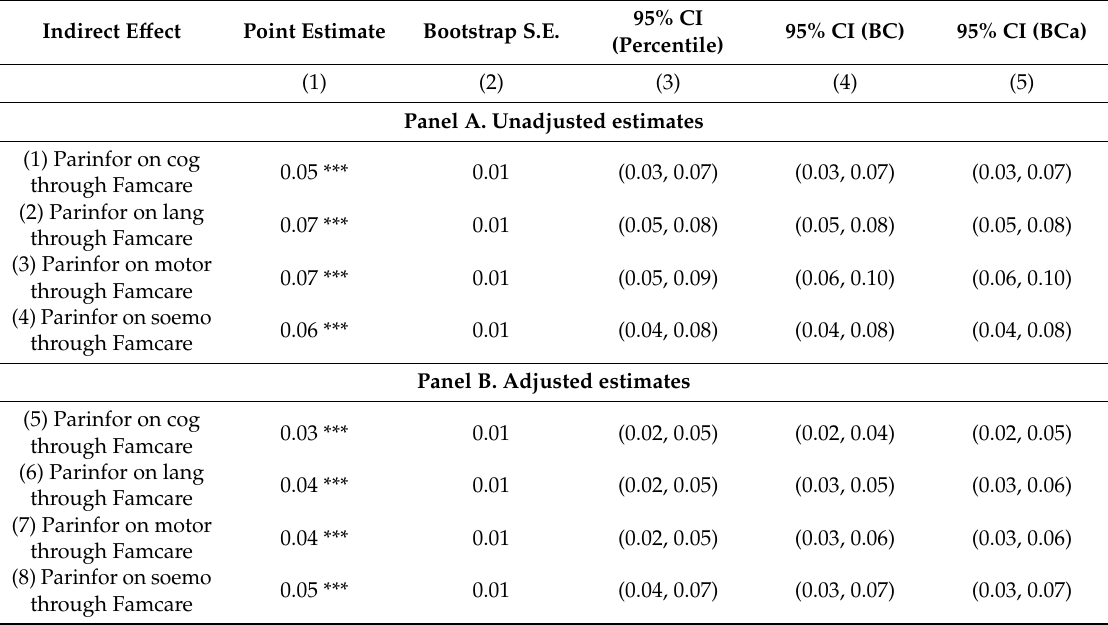
Table 3. Estimates of indirect e ff ects of parenting information on child development through family care. Indirect E ff ect